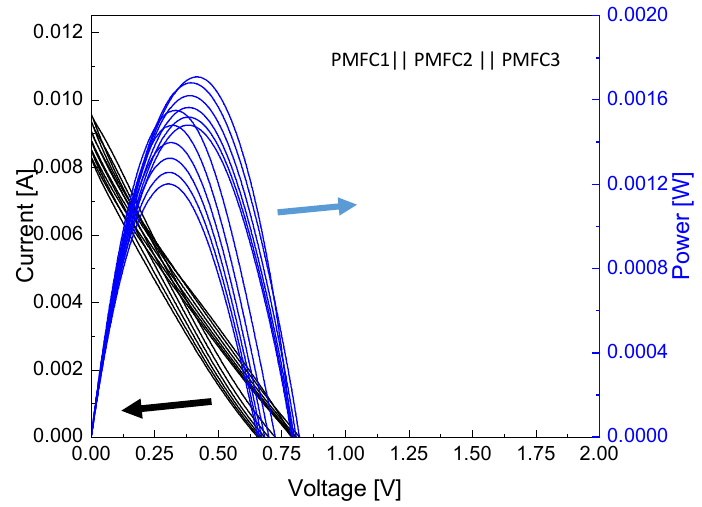
Figure 9. Forage-grass-power fuel cell I-V